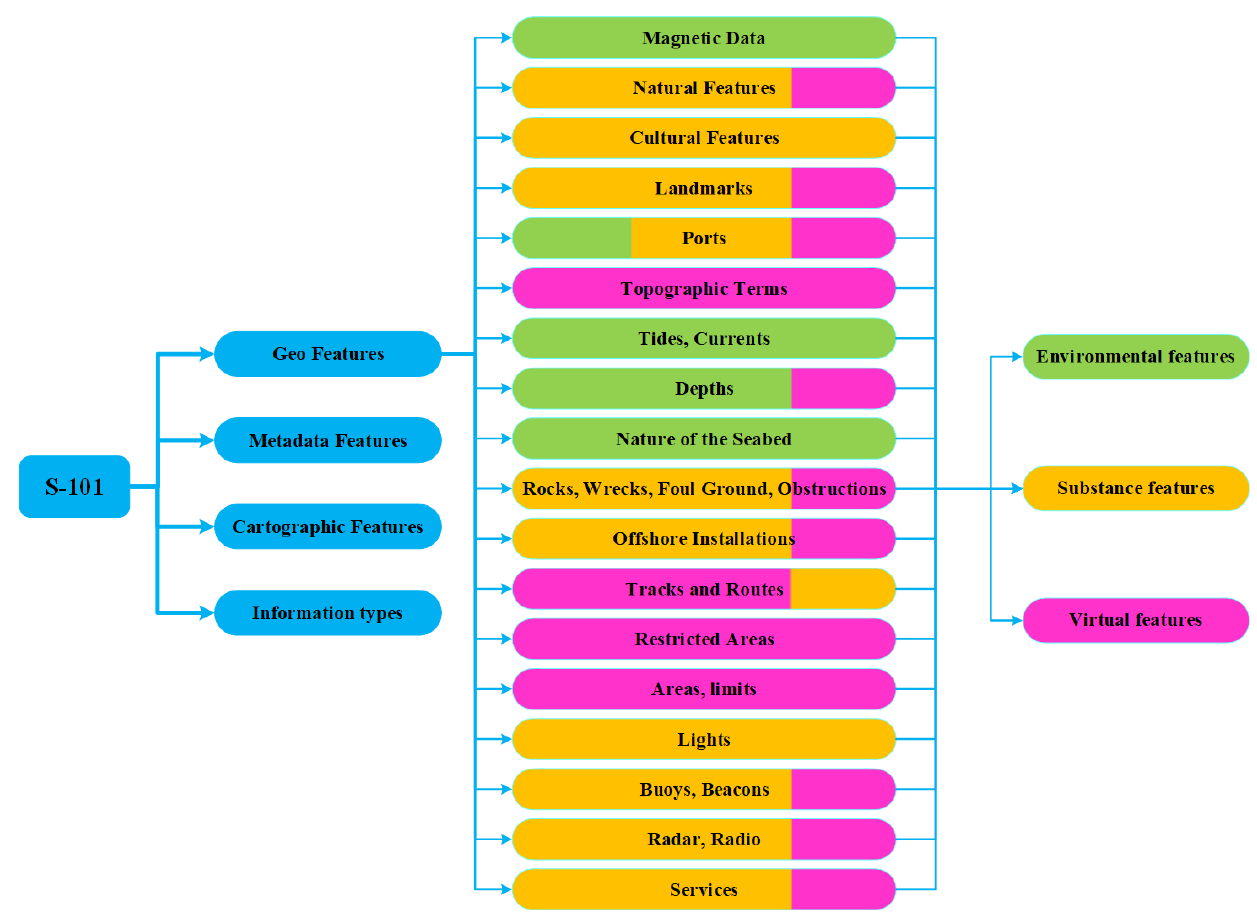
Figure 3. The 3D ENC data